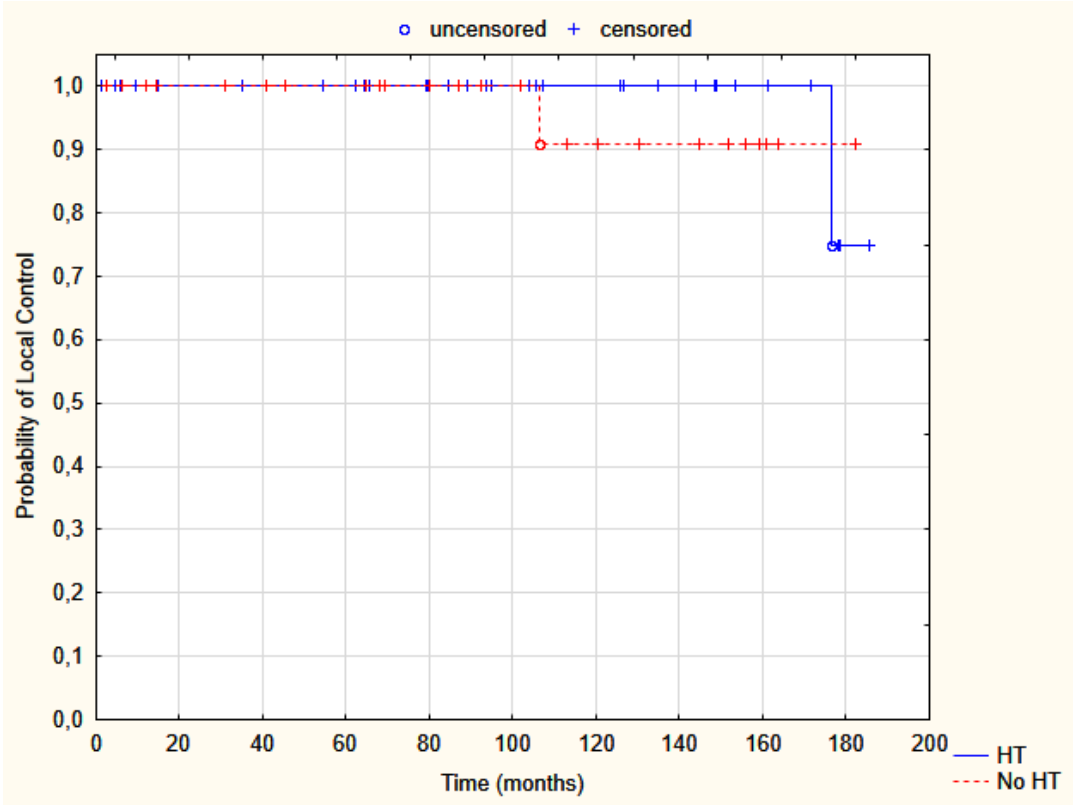
Figure 1. Probability of local control in group A, HDR-BT (red dotted line), and B, HDR-BT + thermal boost (blue solid line); Test log-rank, p = 0.59. HT—hyperthermia.